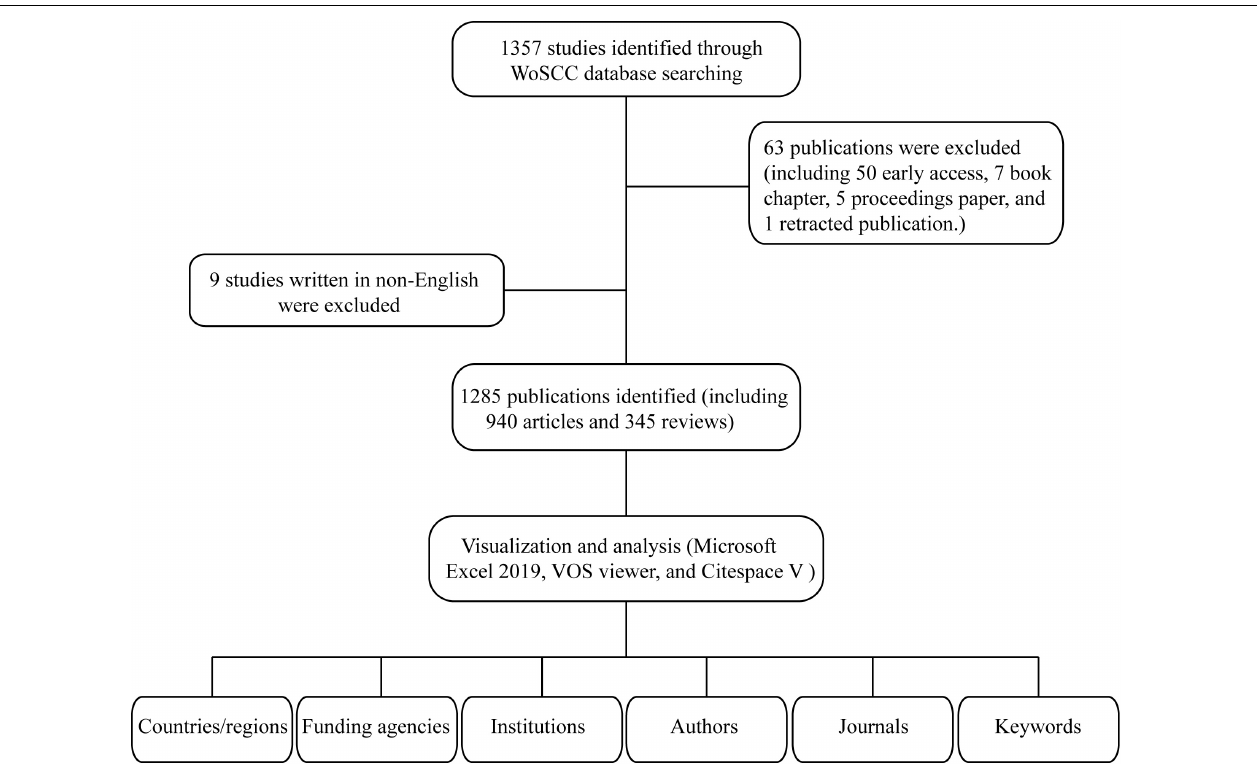
FIGURE 1 | Flowchart for the selection of publications included in this